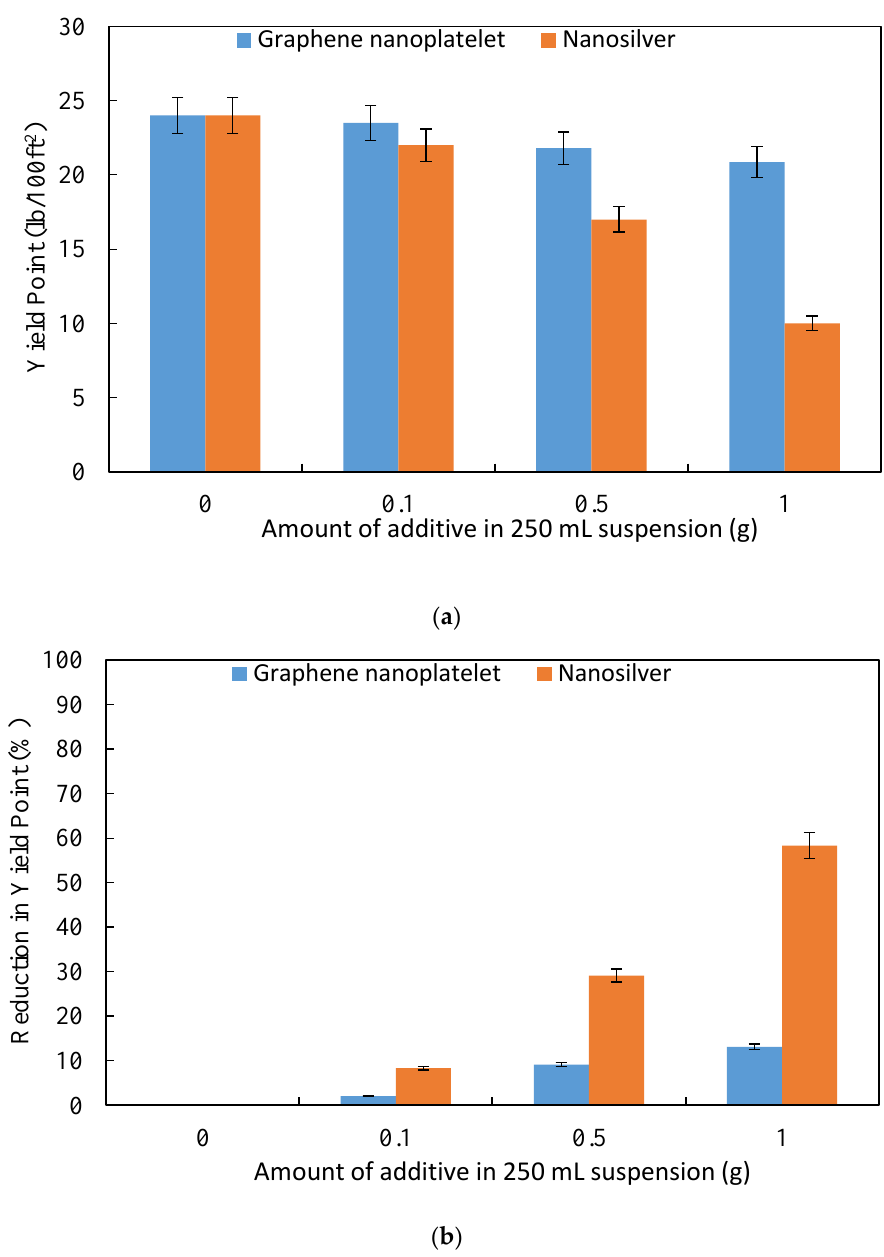
Figure 5. Yield point (YP) measurement of water-based muds with 5% error bar. ( a ) YP measurements, and ( b ) YP percent reduction when graphene nanoplatelet and nanosilver are present.